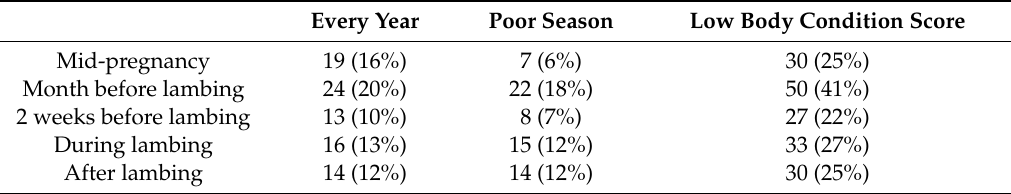
Table 7. A 2019 survey of 121 NSW sheep producers timing of energy and protein supplementation under various conditions and production phases around pregnancy / lambing. Every Year Poor Season Low Body Condition